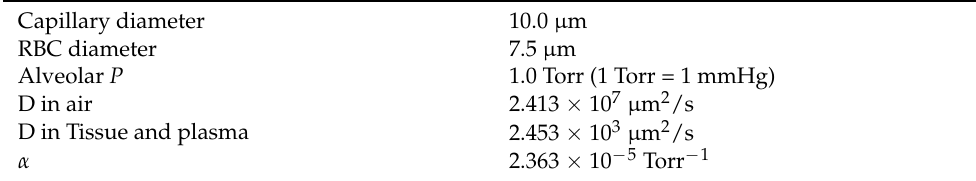
Table 2. List of constants used in the simulation. Capillary